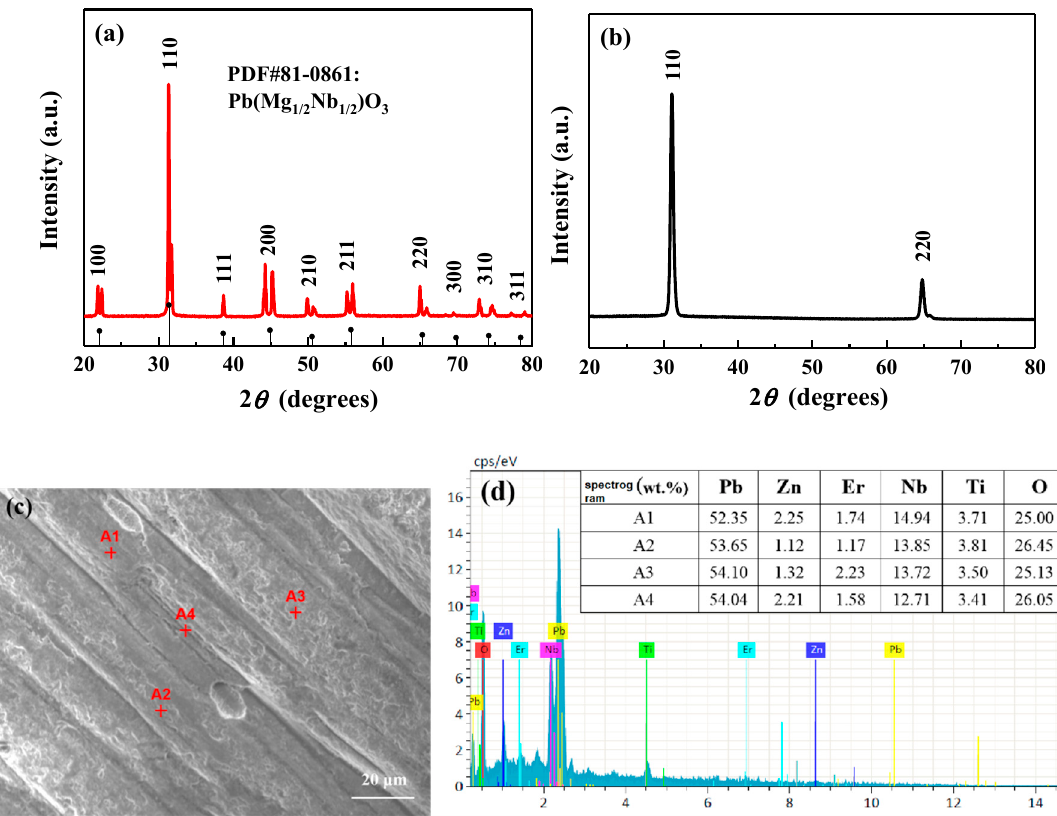
Figure 1. XRD profiles of ( a ) crystal powder and( b ) [110]-oriented crystals. ( c ) An SEM image of the crystals. ( d ) An energy dispersive system (EDS) spectrum of crystals.